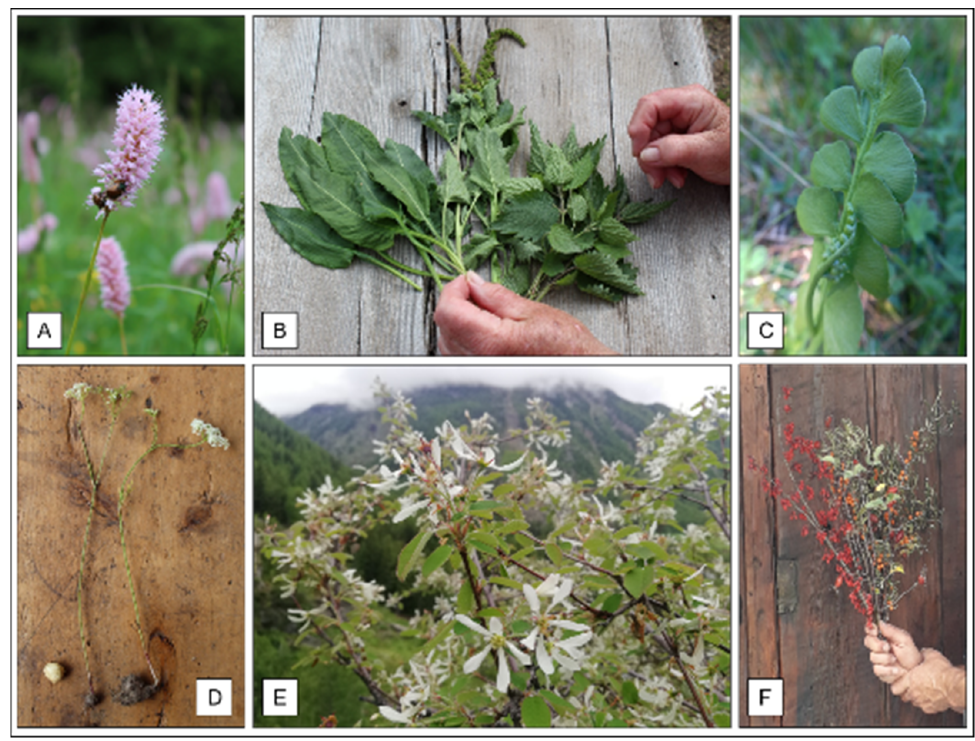
Figure 4. Food plants: ( A ) Bistorta officinalis ; ( B ) Bistorta officinalis , Blitum bonus-henricus , Urtica dioica ; ( C ) Botrychium lunaria ; ( D ) Bunium bulbocastanum ; ( E ) Amelanchier ovalis ; ( F ) Berberis vulgaris , Hippophae rhamnoides , Rosa canina .